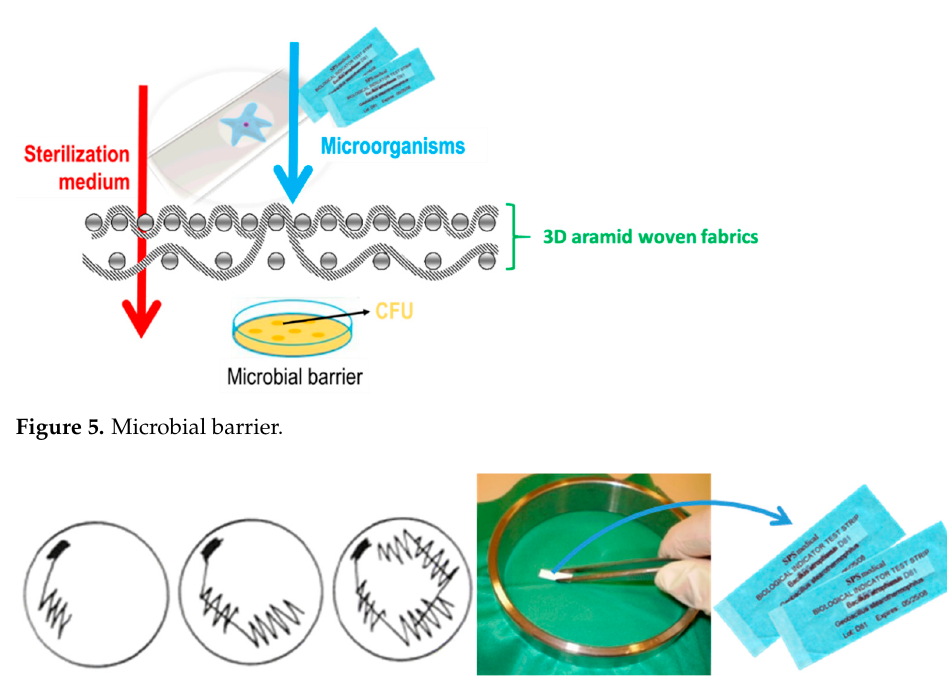
Figure 6. Illustration of the application of bacterial spores of Geobacillus Stearothermophilus and Ba- cillus Atrophaeus to the sample test field.